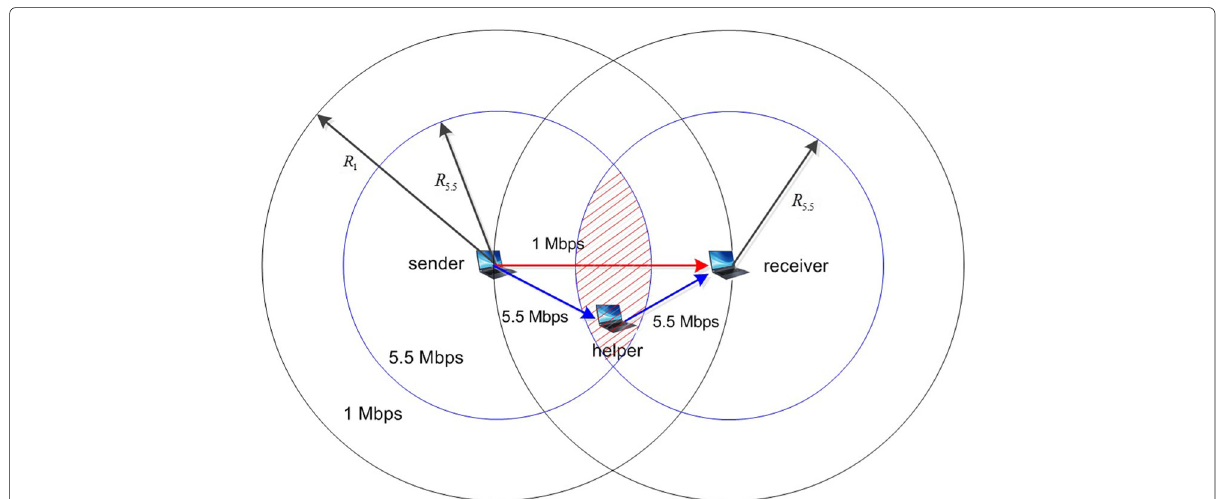
Fig. 1 Example of cooperative